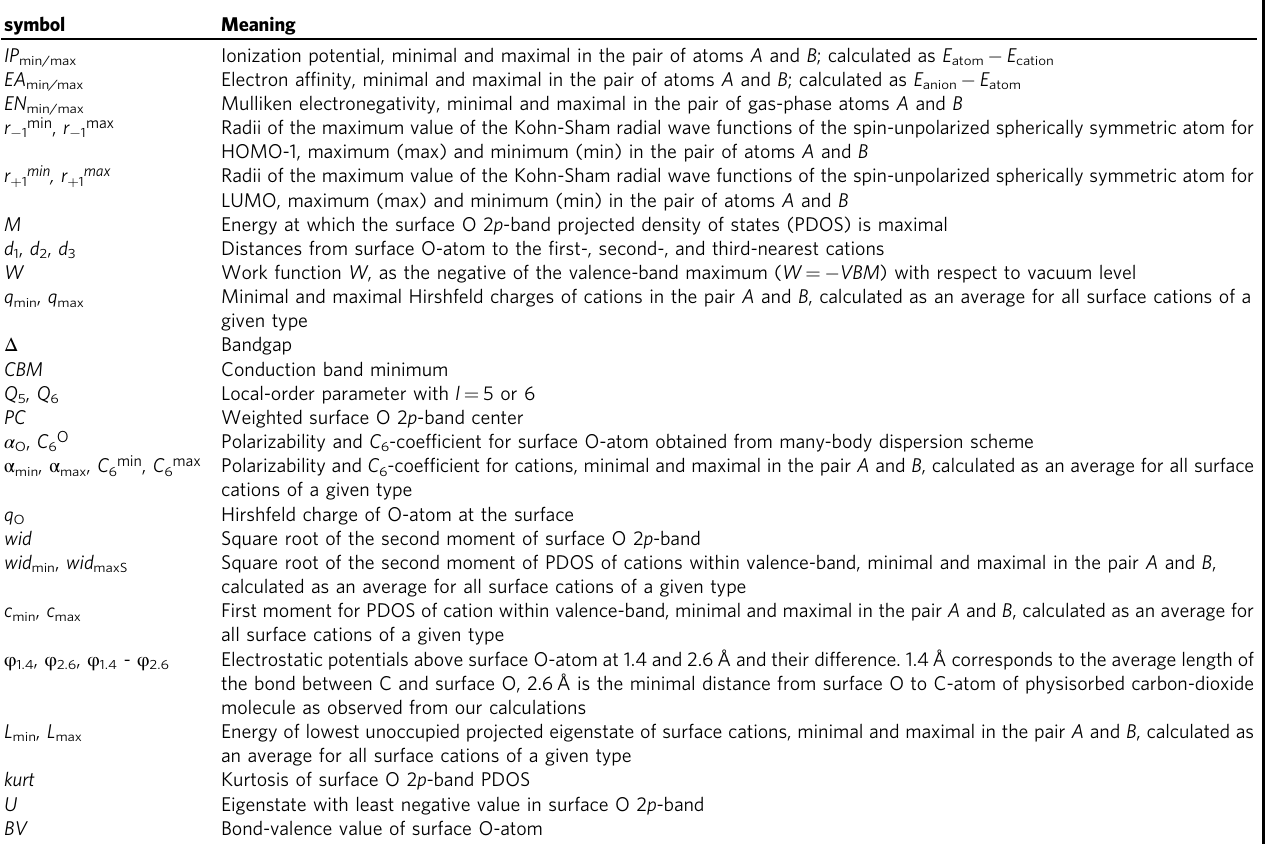
Table 1 Features that appear in the top SGD selectors (see